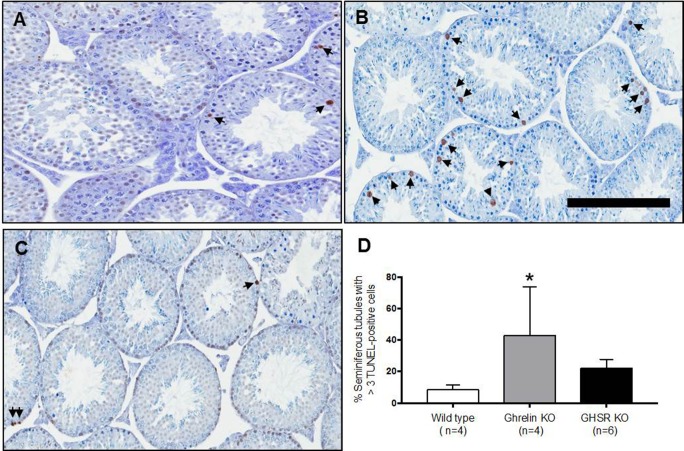
Increased germ cell apoptosis in ghrelin KO mice.Apoptotic germ cells were detected by TUNEL analysis in wild type (A), ghrelin KO (B) and GHSR KO (C) mice. The arrows indicate apoptotic germ cells. Scale bar = 200μm. D) Quantitation of TUNEL-positive cells in wild type, ghrelin KO and GHSR KO mice testes. The data were expressed as the percentage of round seminiferous tubules (ratio major axis/minor axis < 1.5) with more than 3 TUNEL-positive cells. Ghrelin KO mice showed a significant increase in the percentage of seminiferous tubules with >3 TUNEL-positive cells compared to wild type mice. Data were analyzed by one-way ANOVA multiple comparisons Bonferroni's test and expressed as mean ± SEM (* p<0.05).